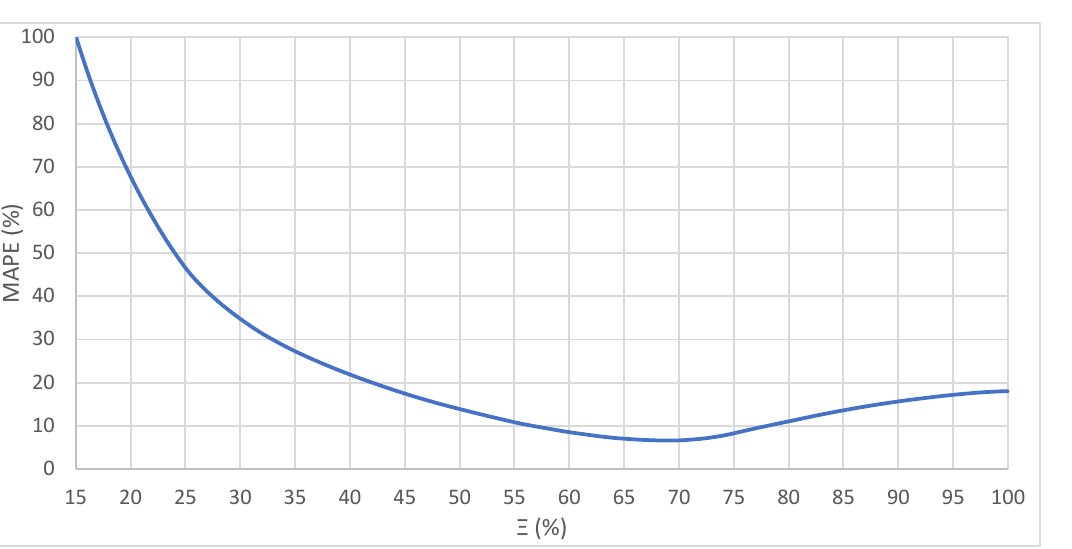
Figure 5. Comparison of Equation (16) results with Dragomirescu [17] and the other Archimedes screw installations (Table 2).